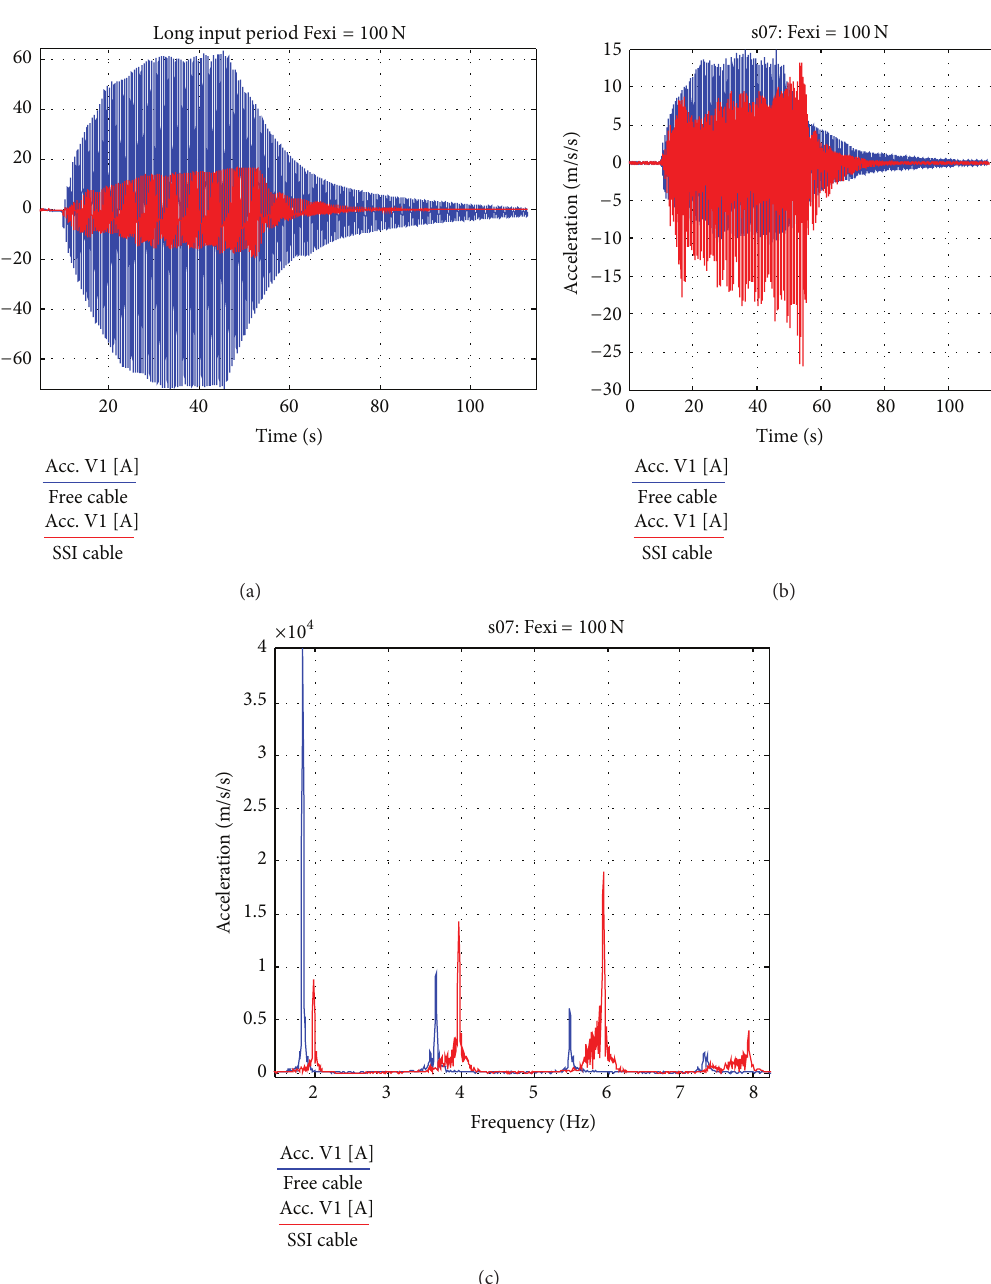
This formulation is available for a zero clearance; the exact amplitude. Moreover, for increasing amplitude, completely formulation for a nonzero clearance is more complex and can different mode shapes may appear by bifurcation for the same be found in [26]. However, depending on the switch position, value of the bilinear frequency. These mode shapes combine [𝑓 − , 𝑓 + ] range. Similarly, the 𝑖 th mode 𝑓 𝑏 free and restrained mode shapes of different order (e.g., 𝑓 − 𝑖 𝑖 may vary in the 𝑖 𝑖 and 𝑓 + 𝑖+1 ). This phenomenon, called internal resonance, is shape is a combination of the 𝑖 th free and restrained mode typical of nonlinear systems. shapes and varies with the switch position. Basically, bilinear During any type of test with varying amplitude (e.g., free frequencies/modes are to bilinear systems what eigenfre- decay after a snap-back or forced vibrations), the response of quencies are to linear systems. However, bilinear frequencies/ a MDoF bilinear system is therefore extremely complex since modes depend not only on the system characteristics (mas- it is a varying combination of varying ses, stiffness, and switching position) but also on the input